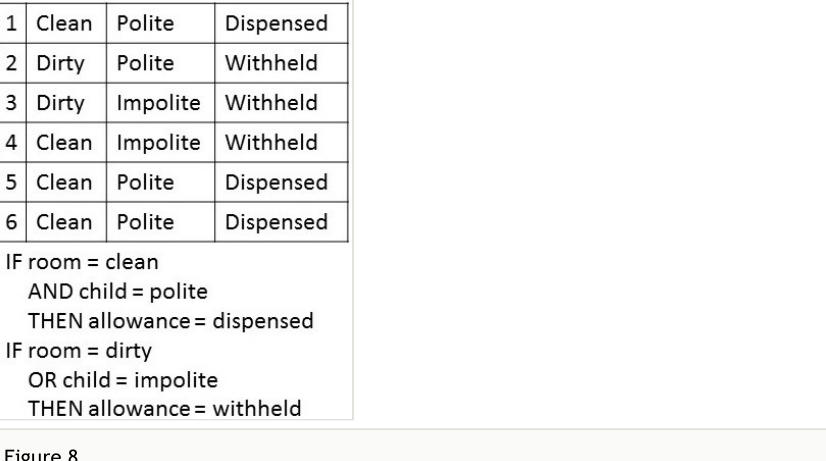
Fuzzy Inference Rule Set . This is a simpli fi ed example of an "if/then" rule set derived from data (in the table) using fuzzy inference. The inferred rules can be used to predict when an allowanced with be